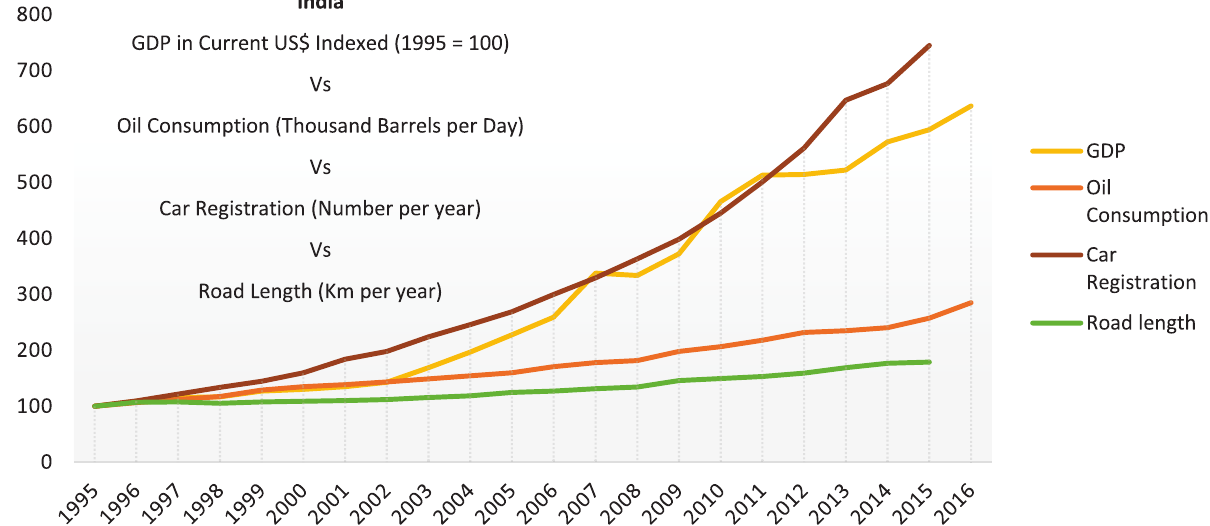
Figure 2. Historic growth rates of GDP, oil consumption, car registration and road length in India. Source: Compiled by au- thor based on data sourced from CEID (2017), EIA (2016), Government of India (2017a), Ministry of Petroleum & Natural Gas (2017), OPEC (2016) and WBG